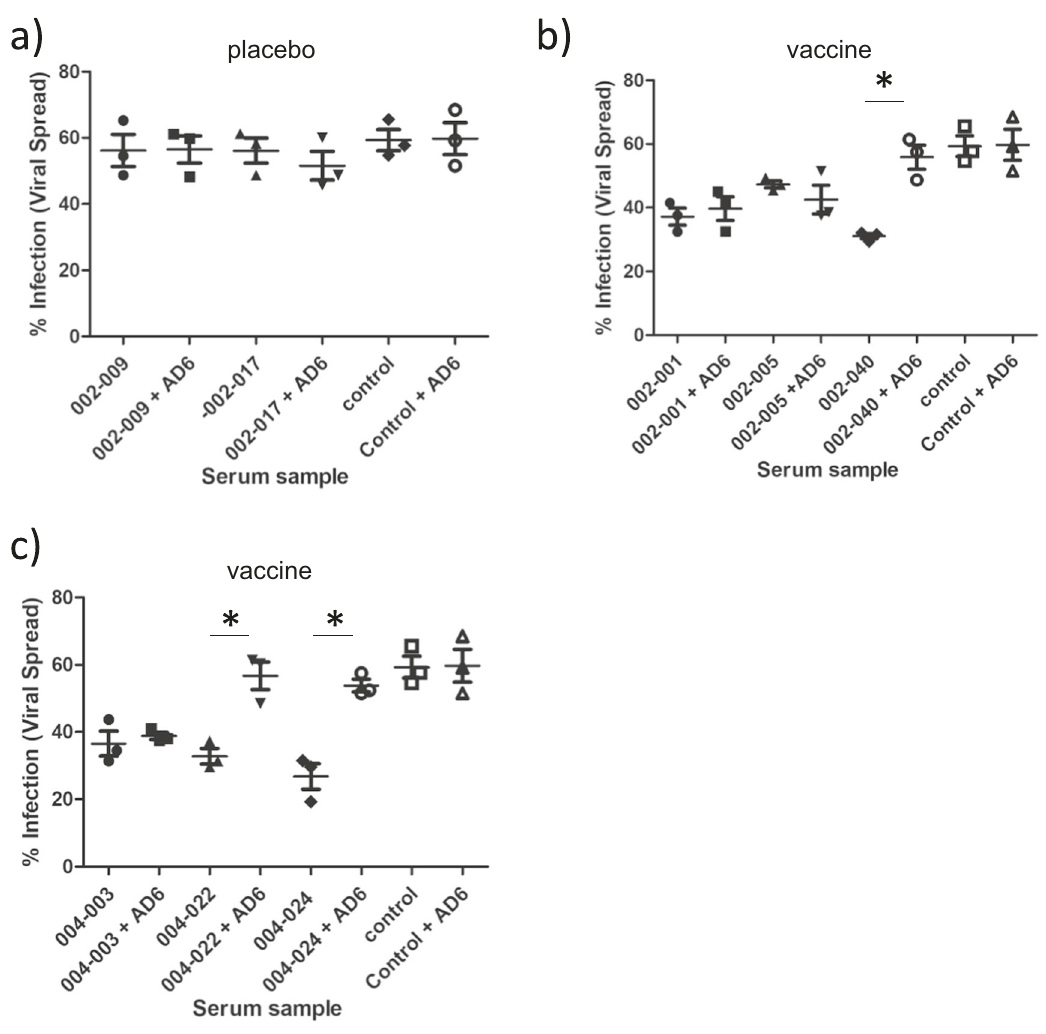
Fig. 7 | The AD-6 polypeptide reverses the control of HCMV spread by humanseratakenfromgBvaccinerecipients.a – c Tomeasurethespreadofcell- associated virus in HFFs, cells were infected with Merlin-IE2-GFP (MOI=0.01). At 1 dpi and 5 dpi, healthy seronegative sera (control), or sera from placebo ( a ) or gB vaccinated ( b , c ) individuals was added at a 1:20 dilution. Additionally, sera were alsopre-incubatedwithAD-6peptidepriortoadditiontotheinfectedcells(+AD-6). 10 dpi, cells were then analysed by IF for viral spread. The percentage of infected